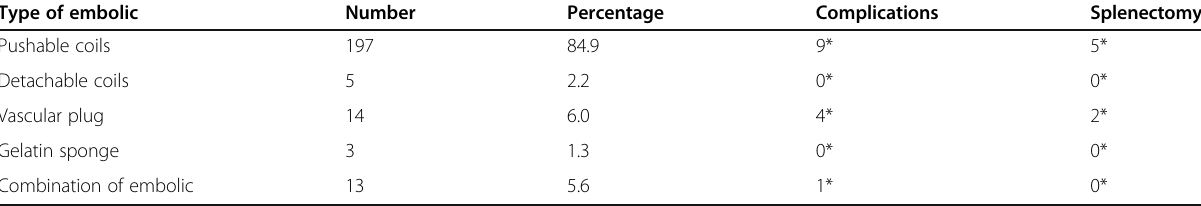
Table 3 Use of different embolic agents, and association with complication and need for splenectomy Type of embolic